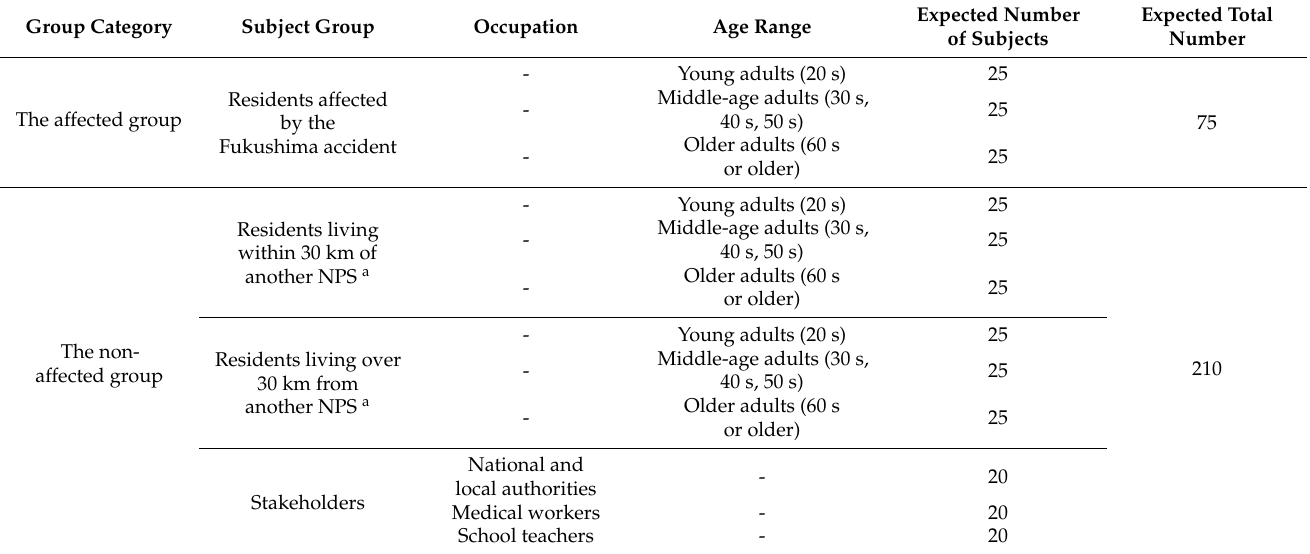
Table 1. Participant allocation and grouping in the internet